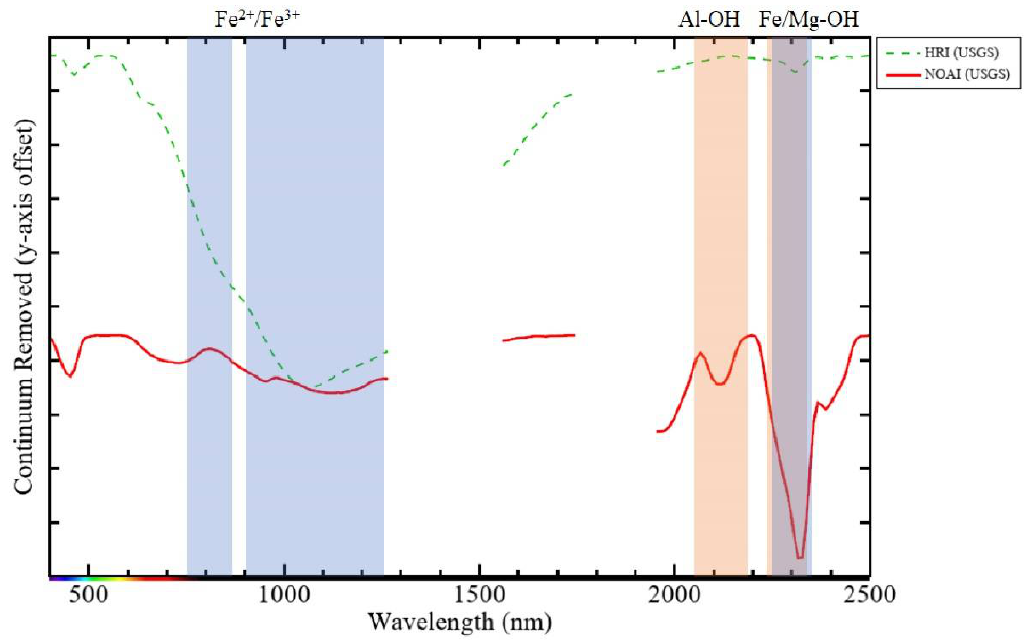
Figure 3. Averaged continuum removed reflectance distributions of reference spectra collected from USGS spectral library. Dashed and solid lines indicate HRI and NOAI. Blue and orange color blocks are multi ranges of MRSFF to extract HRI and NOAI classes, respectively. The ranges also coincided with the major absorptions by ferric/ferrous, Al-, Fe-, and Mg-OH chemical bonds. MRSFF results produce RMSE and scale images. The scale factor indicates an abun- dance of target spectral features where greater scale values represent stronger absorp- tions. In other words, the low RMSE and high scale factors indicate the closest matching of the target material’s spectral signature. We extracted end-member pixels for HRI and NOAI by selecting those at the top 10% scale factor values and lower 10% RMSE values.